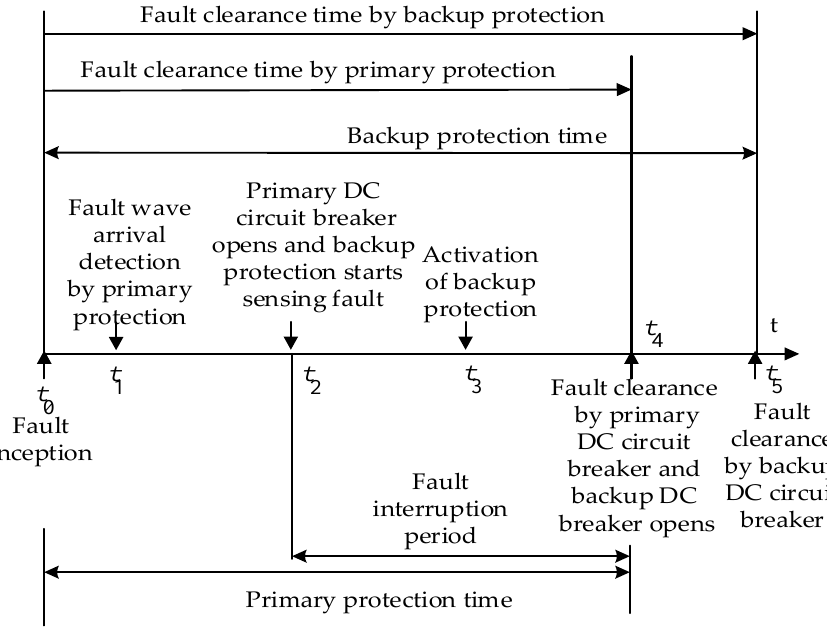
Figure 1. Timing diagram for a direct current (dc) grid protection.